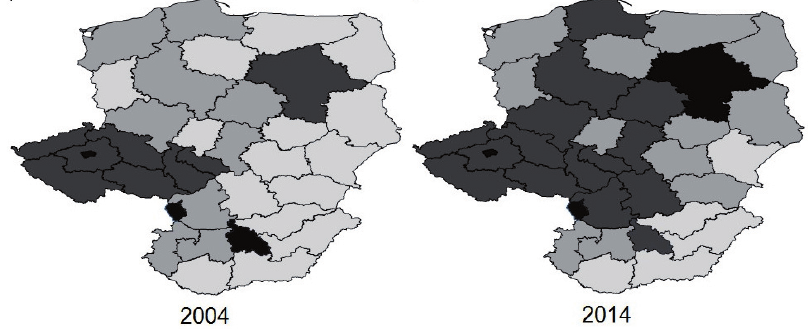
Fig. 1 – K-means grouping of the Visegrad Countries NUTS-2 regions in 2004 and 2014. Source: Author’s own investigation.